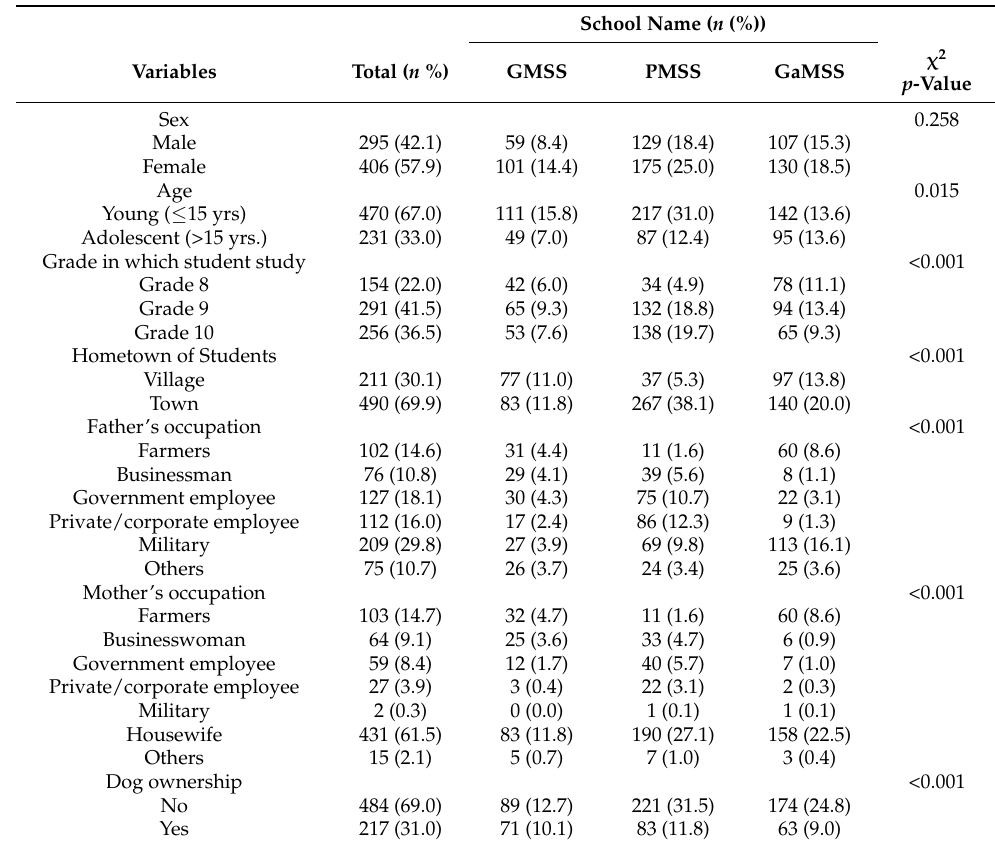
Table 1. Socio-demographic characteristics of the students that participated in the study from three middle secondary schools located in rabies endemic areas of Bhutan (PMSS: Phuntsholing